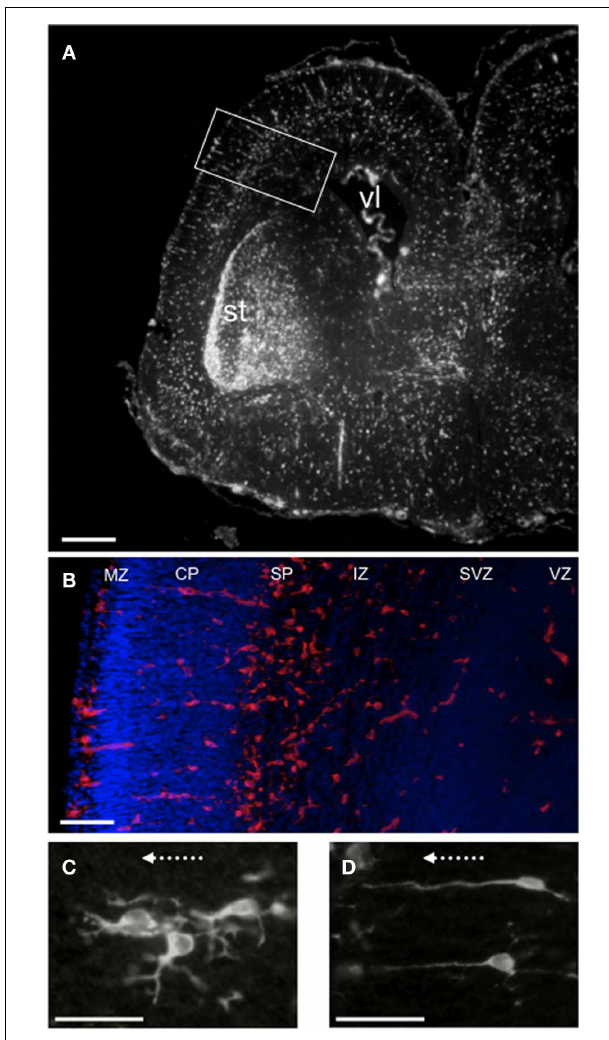
FIGURE 1 | Distribution of Egr-1-d2EGFP transgene expression in the embryonic rat brain. Representative fluorescence microscopic images of E20 brain showing immunohistochemically detected GFP + cells. (A) One hemisphere showing two major populations of GFP + cells: a dense group of cells in the striatum (st) and secondly, cells distributed across different regions, from the border of the lateral ventricle (vl) to the pial surface. Scale bar = 200 μ m. (B) Enlargement of boxed region in (A) showing GFP + cells (red) in different zones demarcated by DAPI (blue). Scale bar = 100 μ m. (C,D) Examples of GFP + cells in the cortical plate illustrating the diverse cellular morphologies that are revealed by transgene GFP cell-filling: (C) branched processes projecting laterally; (D) single processes projecting to the pial surface. Arrows are positioned 90˚ to pial surface. Scale bar = 50 μ m. Abbreviations: CP, cortical plate; IZ, intermediate zone; MZ, marginal zone; SP, subplate; st, striatum; SVZ, sub-ventricular zone; vl, lateral ventricle;VZ, ventricular